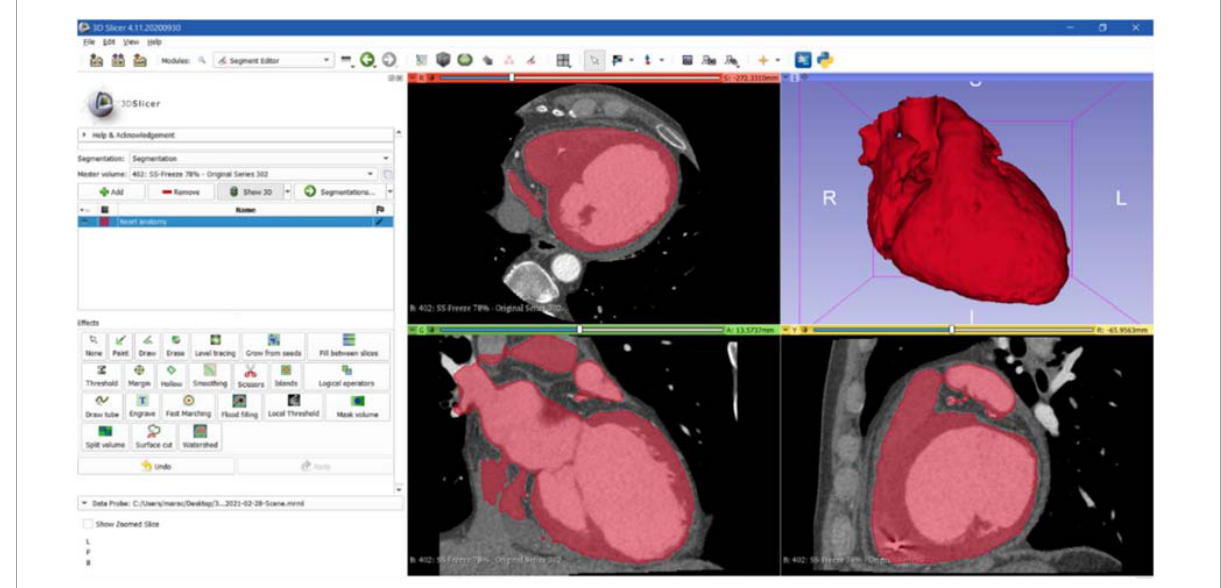
FIGURE3 CT segmentation. Axial, sagittal, coronal, and 3D views of CT segmentation on the 3D Slicer software.